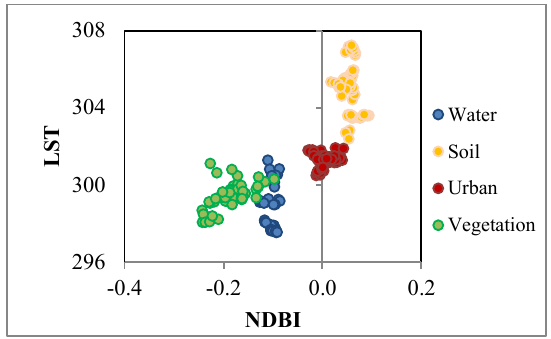
Figure8. LST-NDBI relation with land cover Negative values of NDBI shows waterbodies as well as vegetation which shows lower LST values and higher LST land covers i.e. urban and bare soil regions shows NDBI values nearby or greater than zero. This explains the linear relation of LST with NDBI. Hence, NDBI can be used to study LST in region containing heterogeneous land